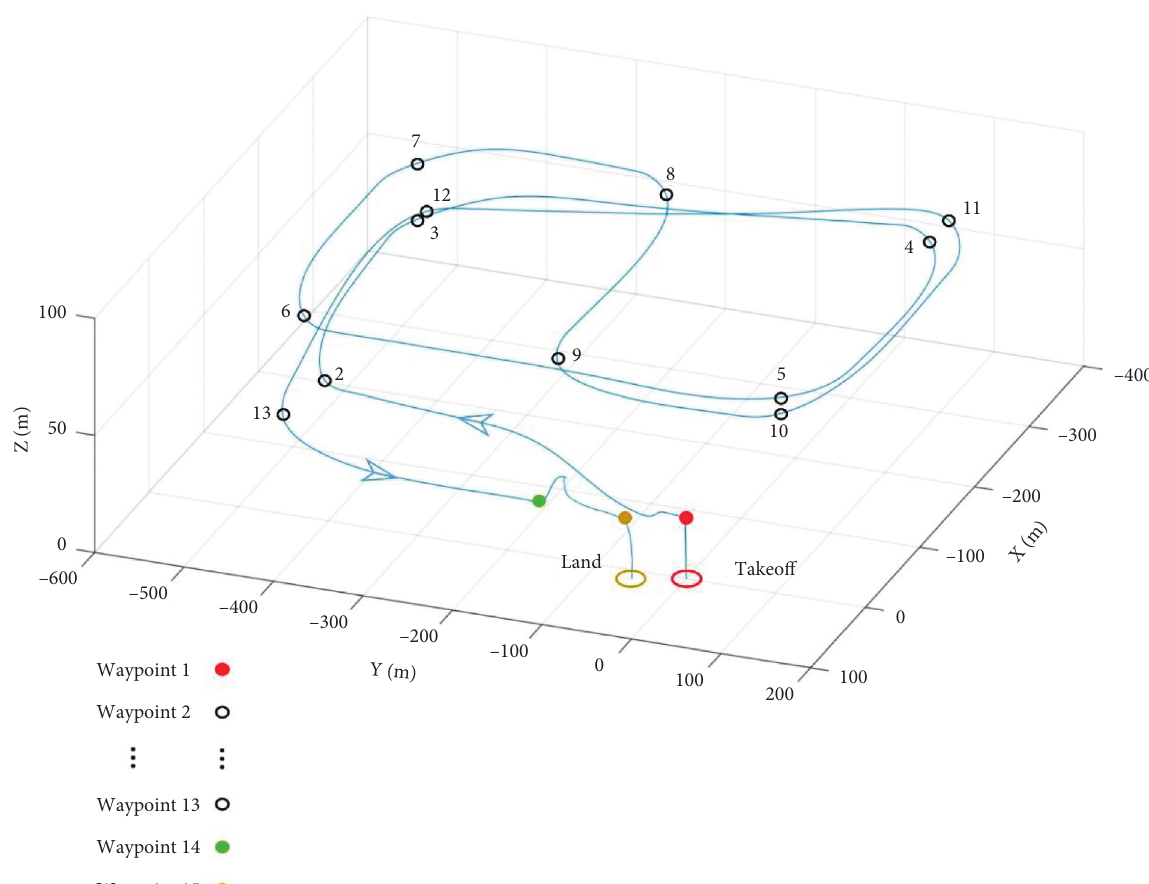
Figure 14: Flight trajectory of the aircraft in HIL